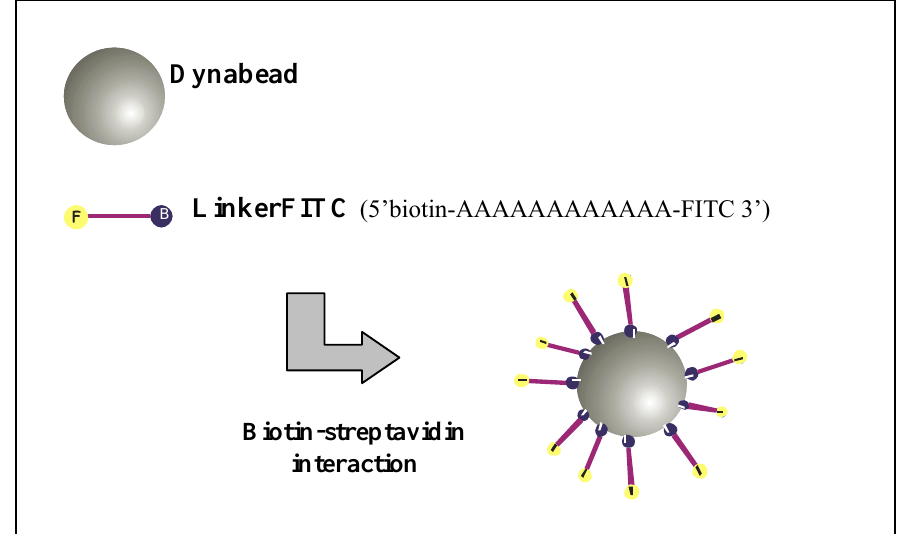
Figure 3. Schematic representation of LinkerFITC (biotinylated probe modified with FITC) bound to Dynabeads by the biotin-streptavidin